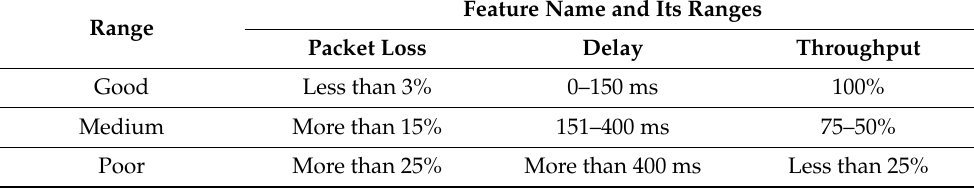
Table 6. Ranges of the selected